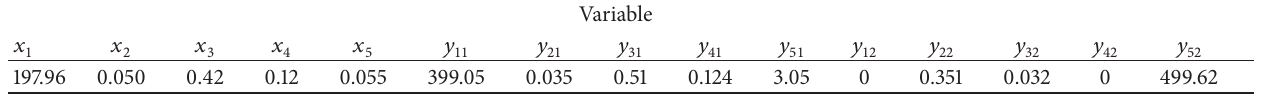
Table 4: Optimal solution by hybrid intelligent